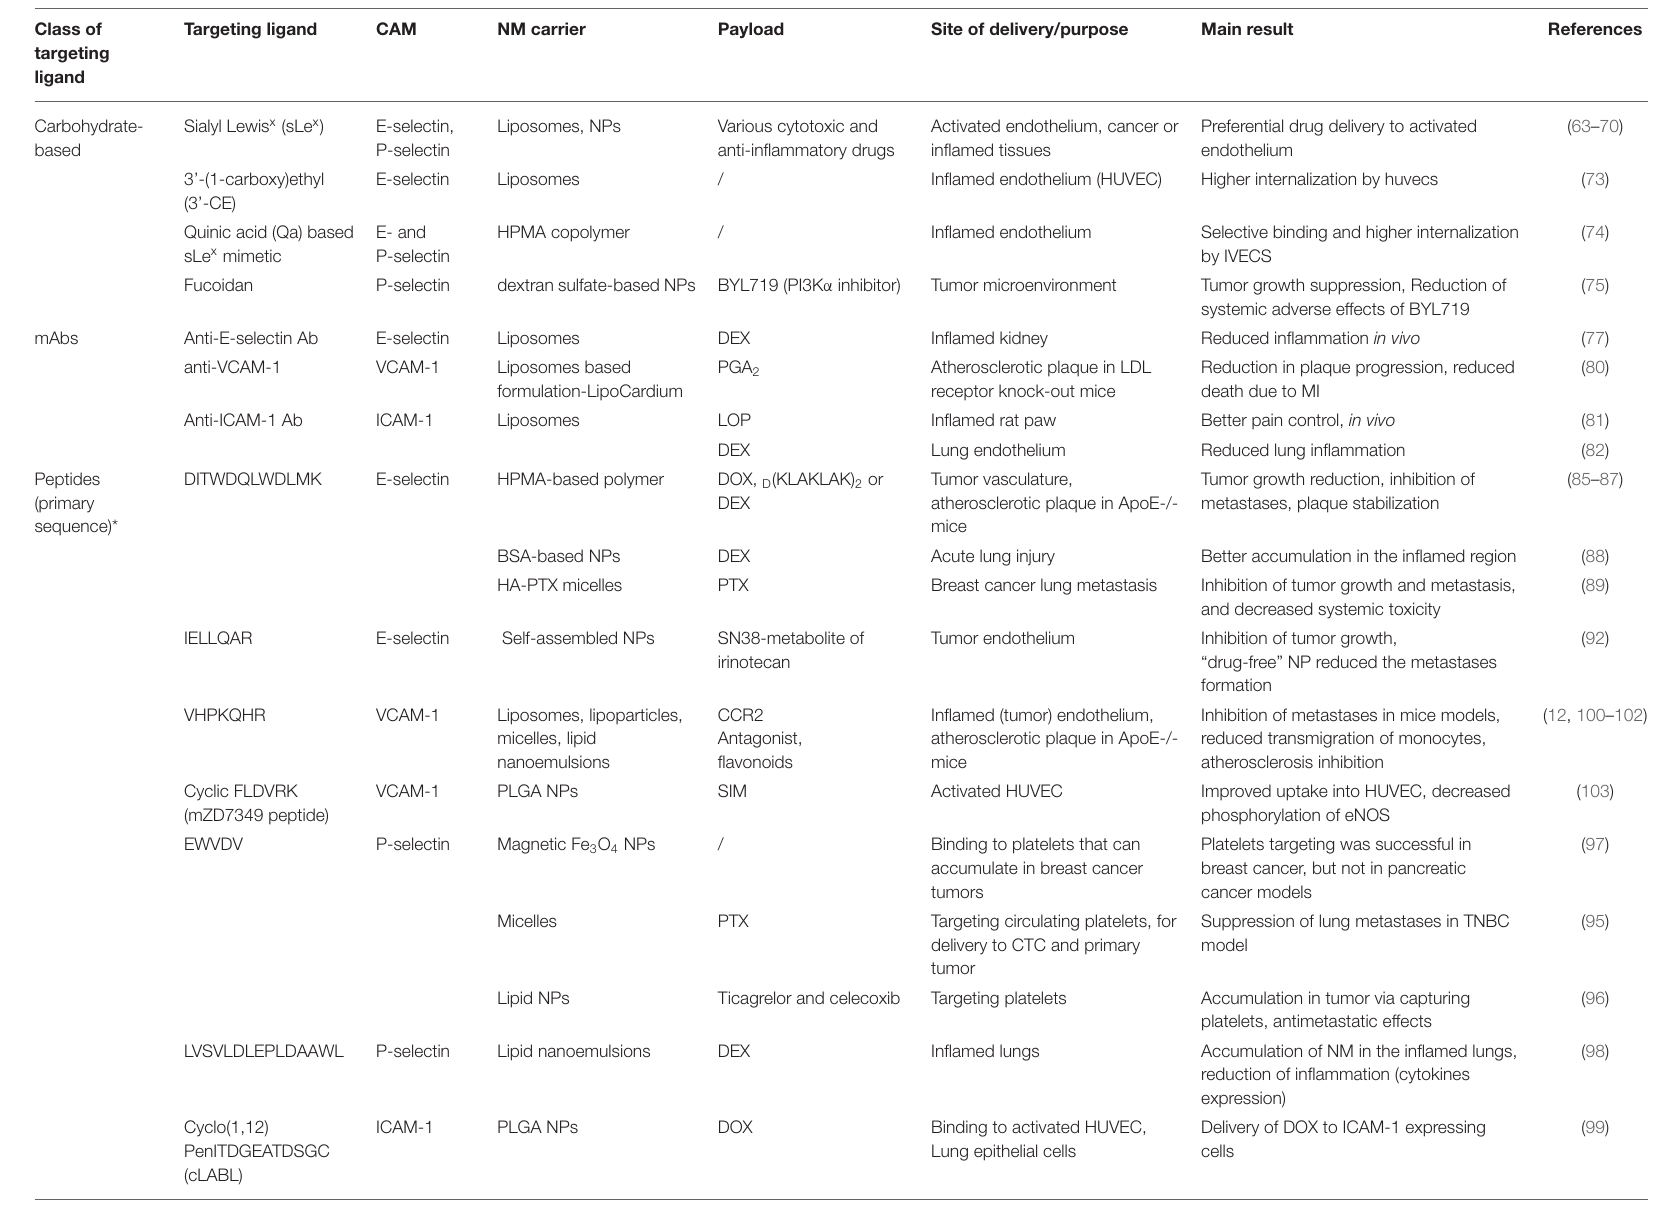
TABLE 2 | Selected examples of NM targeting CAMs for drug